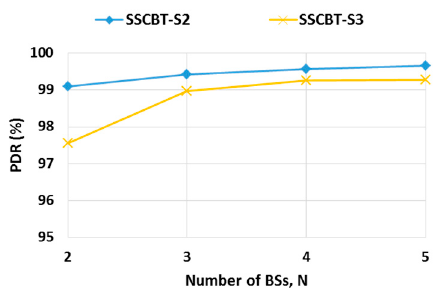
Figure 10. The optimal number of BSs with CW fixed to three.